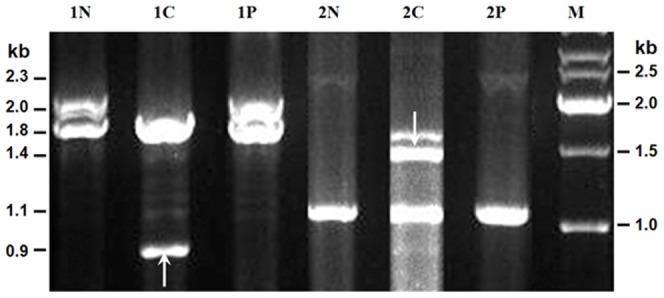
Instability of MUC5AC-u repetitive region in normal, para-carcinoma, and cancer tissues from patients with gastric cancers.Genomic DNA was analyzed from cancer, para-carcinoma and surrounding normal tissues of patients. The sizes of MUC5AC-u repetitive region were analyzed by PCR. N indicated gastric normal tissues, C indicated cancer tissues, P indicated para-carcinoma tissues, and M indicated the size marker. Rearrangements in cancer tissues are indicated by arrows. Heterozygotes have an additional hetero-duplex band (lane of 2C).